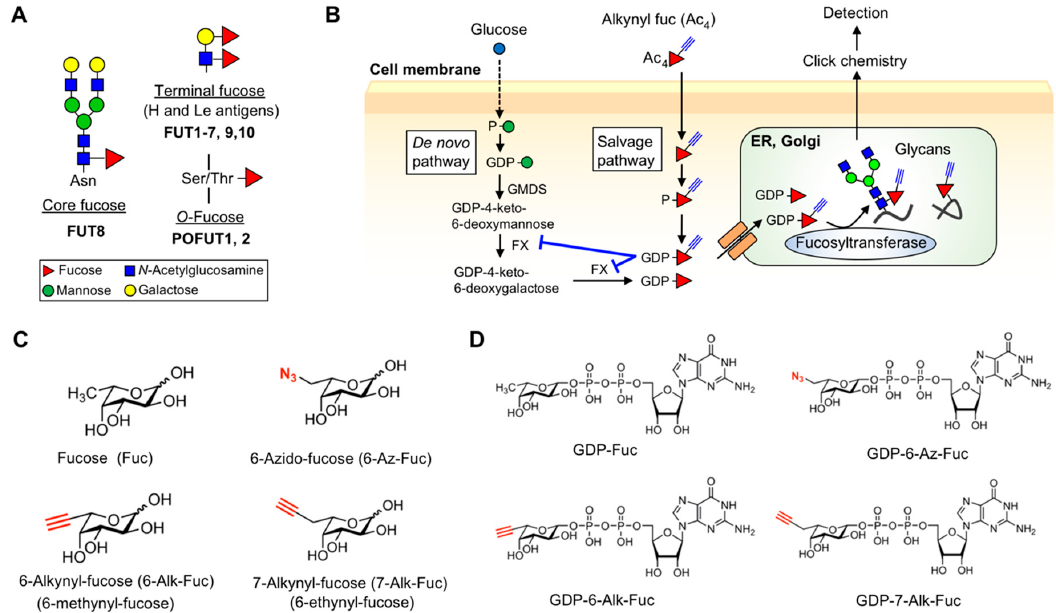
Figure 1. Structure and biosynthesis of fucosylated glycans. ( A ) Structures of fucosylated glycans in mammals. Note that Lewis (Le)-type glycans can be fucosylated on the Gal or GlcNAc, or both. ( B ) Schematic drawing of the biosynthetic pathway of fucosylated glycans in cells. GDP-6-Alk-Fuc inhibits FX. Ac 4 indicates a peracetylated form. ( C ) Chemical structures of Fuc and its analogs used in this study. ( D ) Chemical structures of GDP-Fuc and its analogs used in this study. The glycan biosynthetic pathway can also be exploited or shut down by externally supplied sugar analogs, resulting in labeling or functional inhibition of target